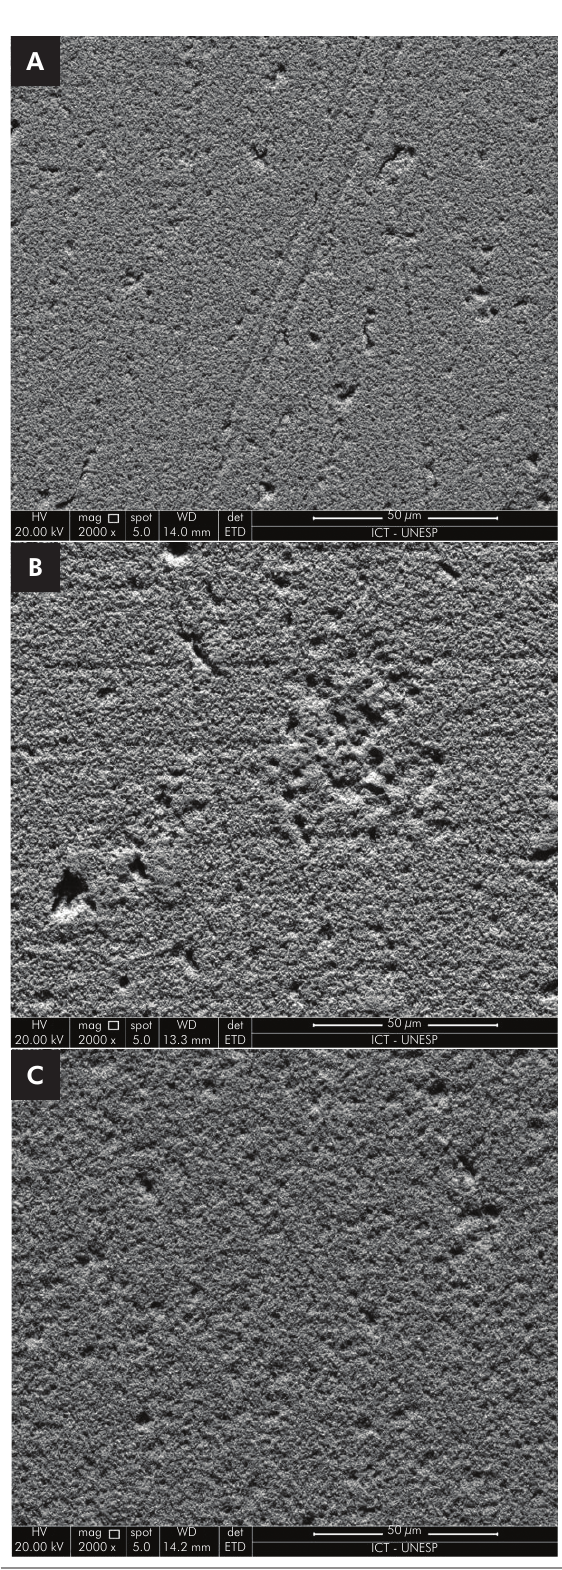
Figure 4. SEM (2000X) micrographs of the ceramic surface with different treatments. A: 5% HF for 60s; B: 5% HF for 120s; C: 10% HF for 60s; D: 10% HF for